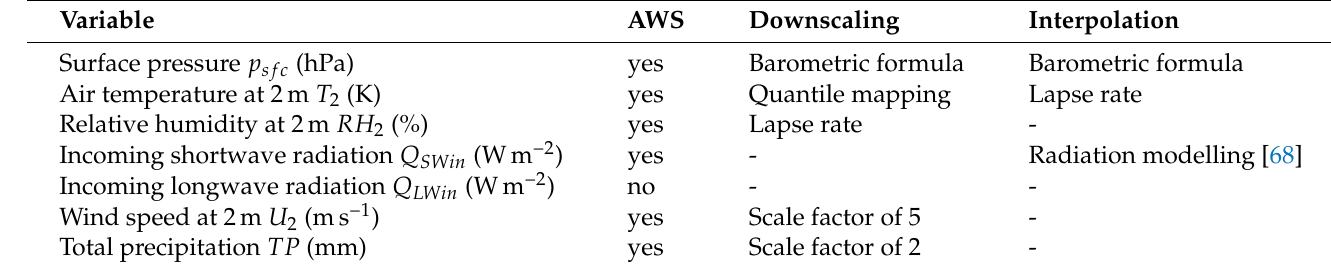
Table 2. COupled Snowpack and Ice surface energy and mass balance model in PYthon (COSIPY) forcing variables with required units, applied downscaling approaches to ERA5-L data and approaches to create the distributed fields (interpolation) on the glacier. The second column denotes if the variable is also measured by the automatic weather station (AWS). A dash stands for no